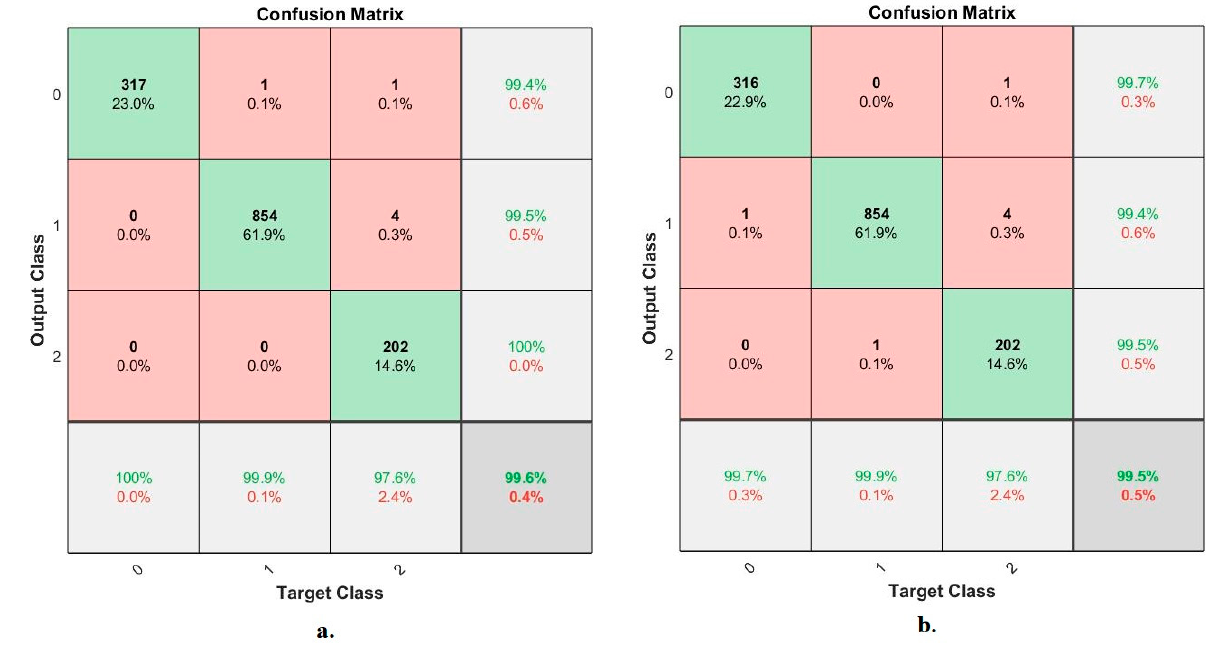
Figure 14. Confusion matrix for diagnosing the X ‐ ray images of pneumonia and tuberculosis using the ANN with features ( a ). VGG16 and LDG; ( b ). ResNet18 and LDG.